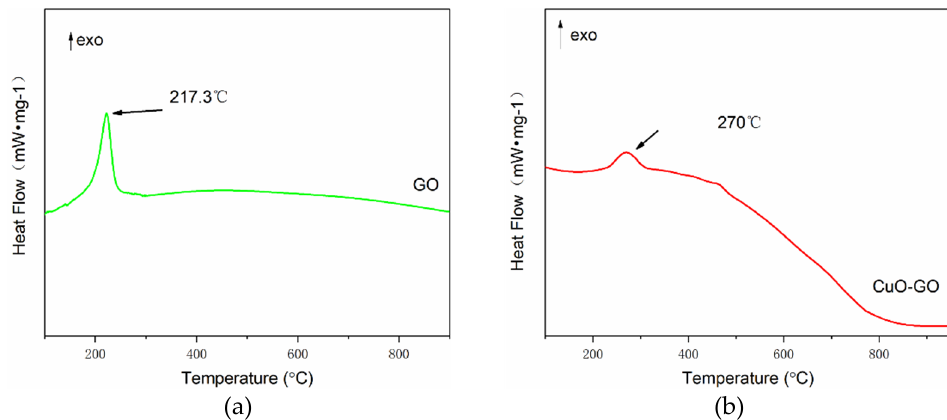
Figure 8. The DSC curves of ( a ) GO and ( b ) CuO–GO.